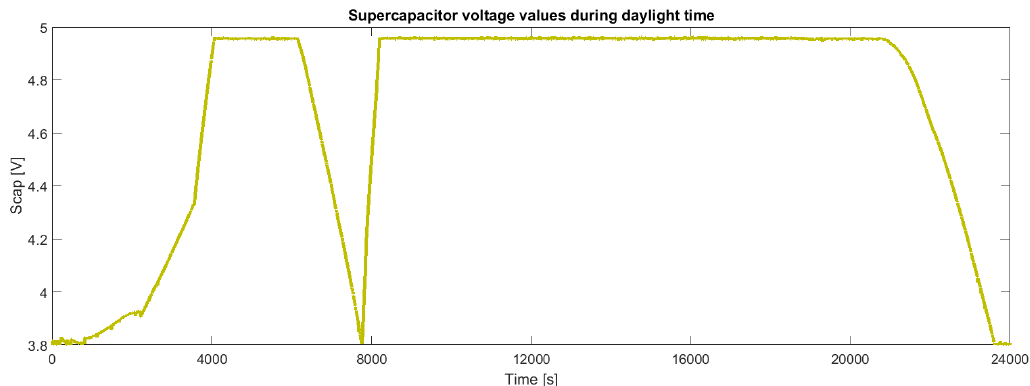
Figure 11. Behavior of the voltage of the supercapacitor during continuous